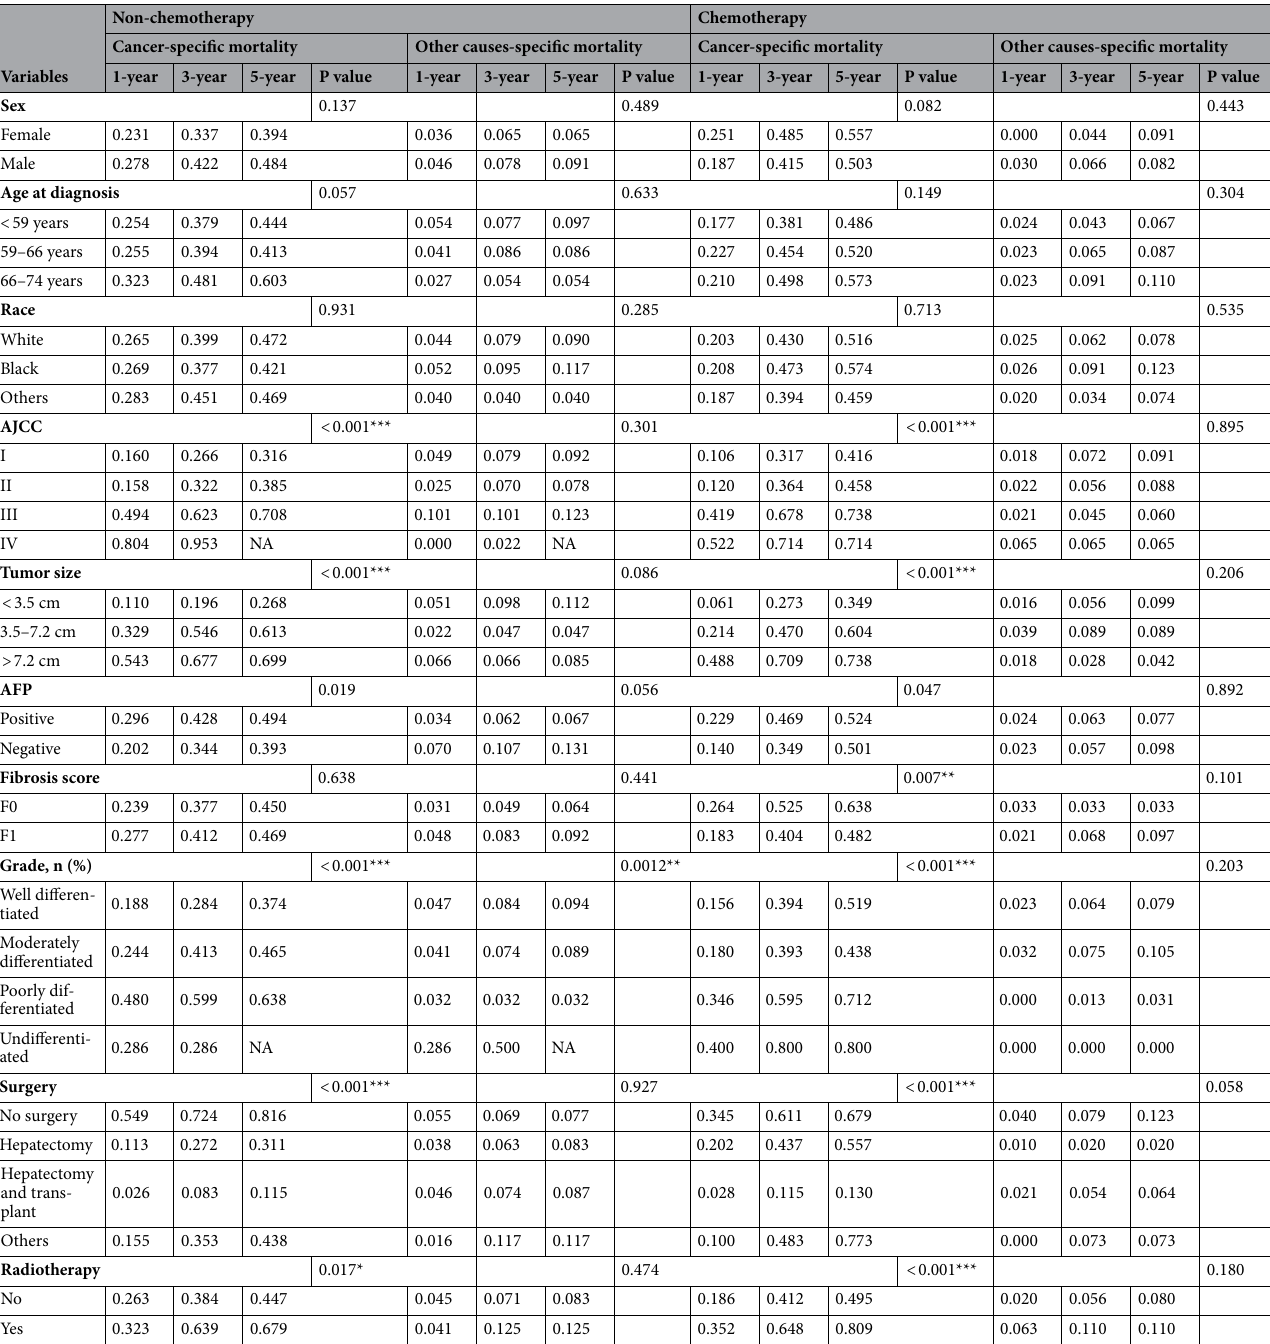
Table 4. Cumulative cancer-specific mortality and other causes-specific mortality of patients with HCC stratified for chemotherapy. *Two-sided P values < 0.05. **Two-sided P values < 0.01. ***Two-sided P values < 0.001. AJCC, American Joint Committee on Cancer (7th). F0, fibrosis score 0–4, non to moderate fibrosis; F1, fibrosis score 5–6, severe fibrosis and